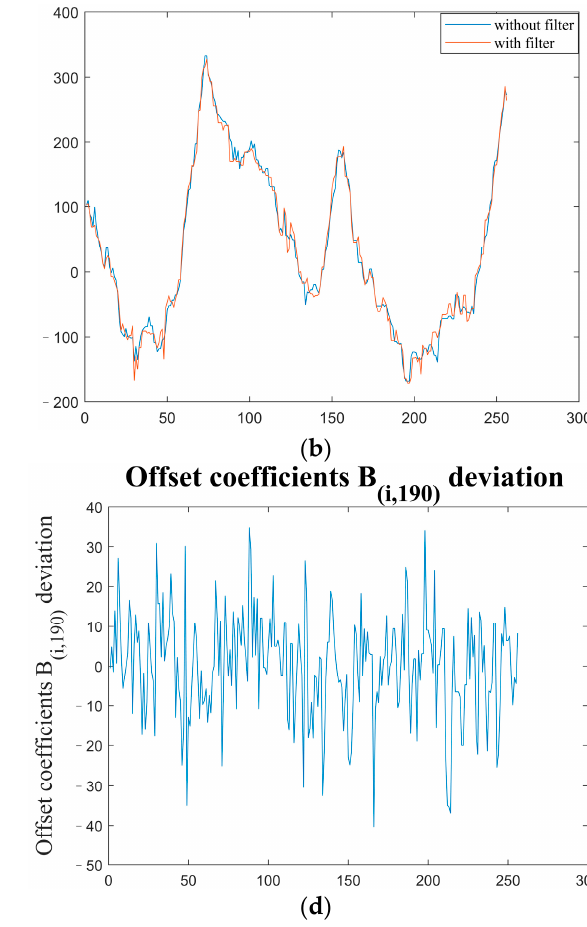
Figure 17. TPC offset coefficients B i,j deviation with and without atmospheric transmittance equiv- alent analog filter.